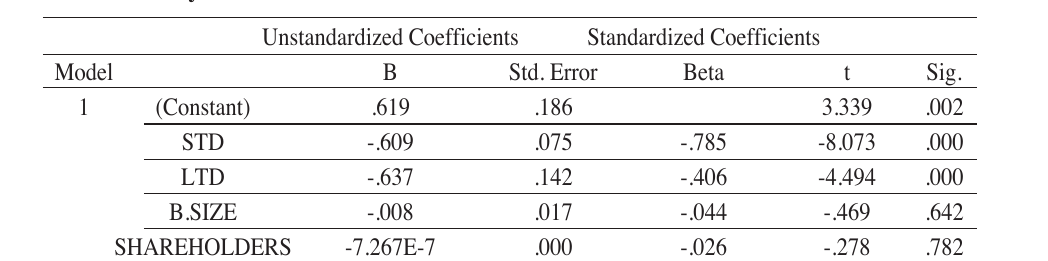
Table 5: Analysis of Coefficientst